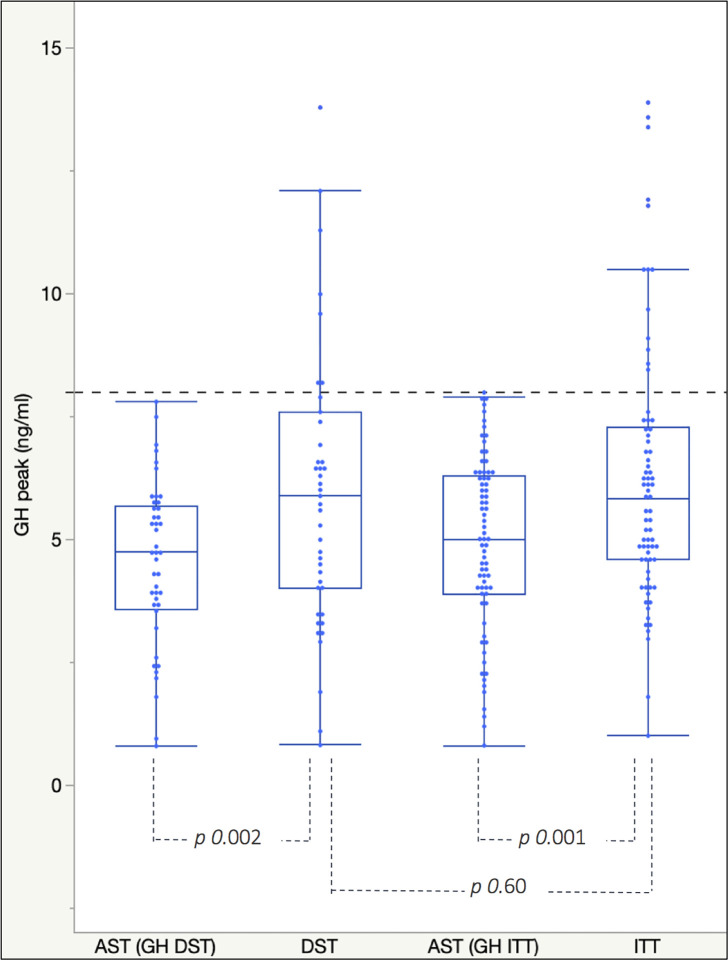
Box plots for mean and interquartile range of GH peaks achieved after AST and ITT/DST in the GH-PAT0ITT and GH-PAT0DST subgroups. The dotted blue line represents the cut-off of 8 ng/ml used to discriminate between GH deficient and not-deficient patients.